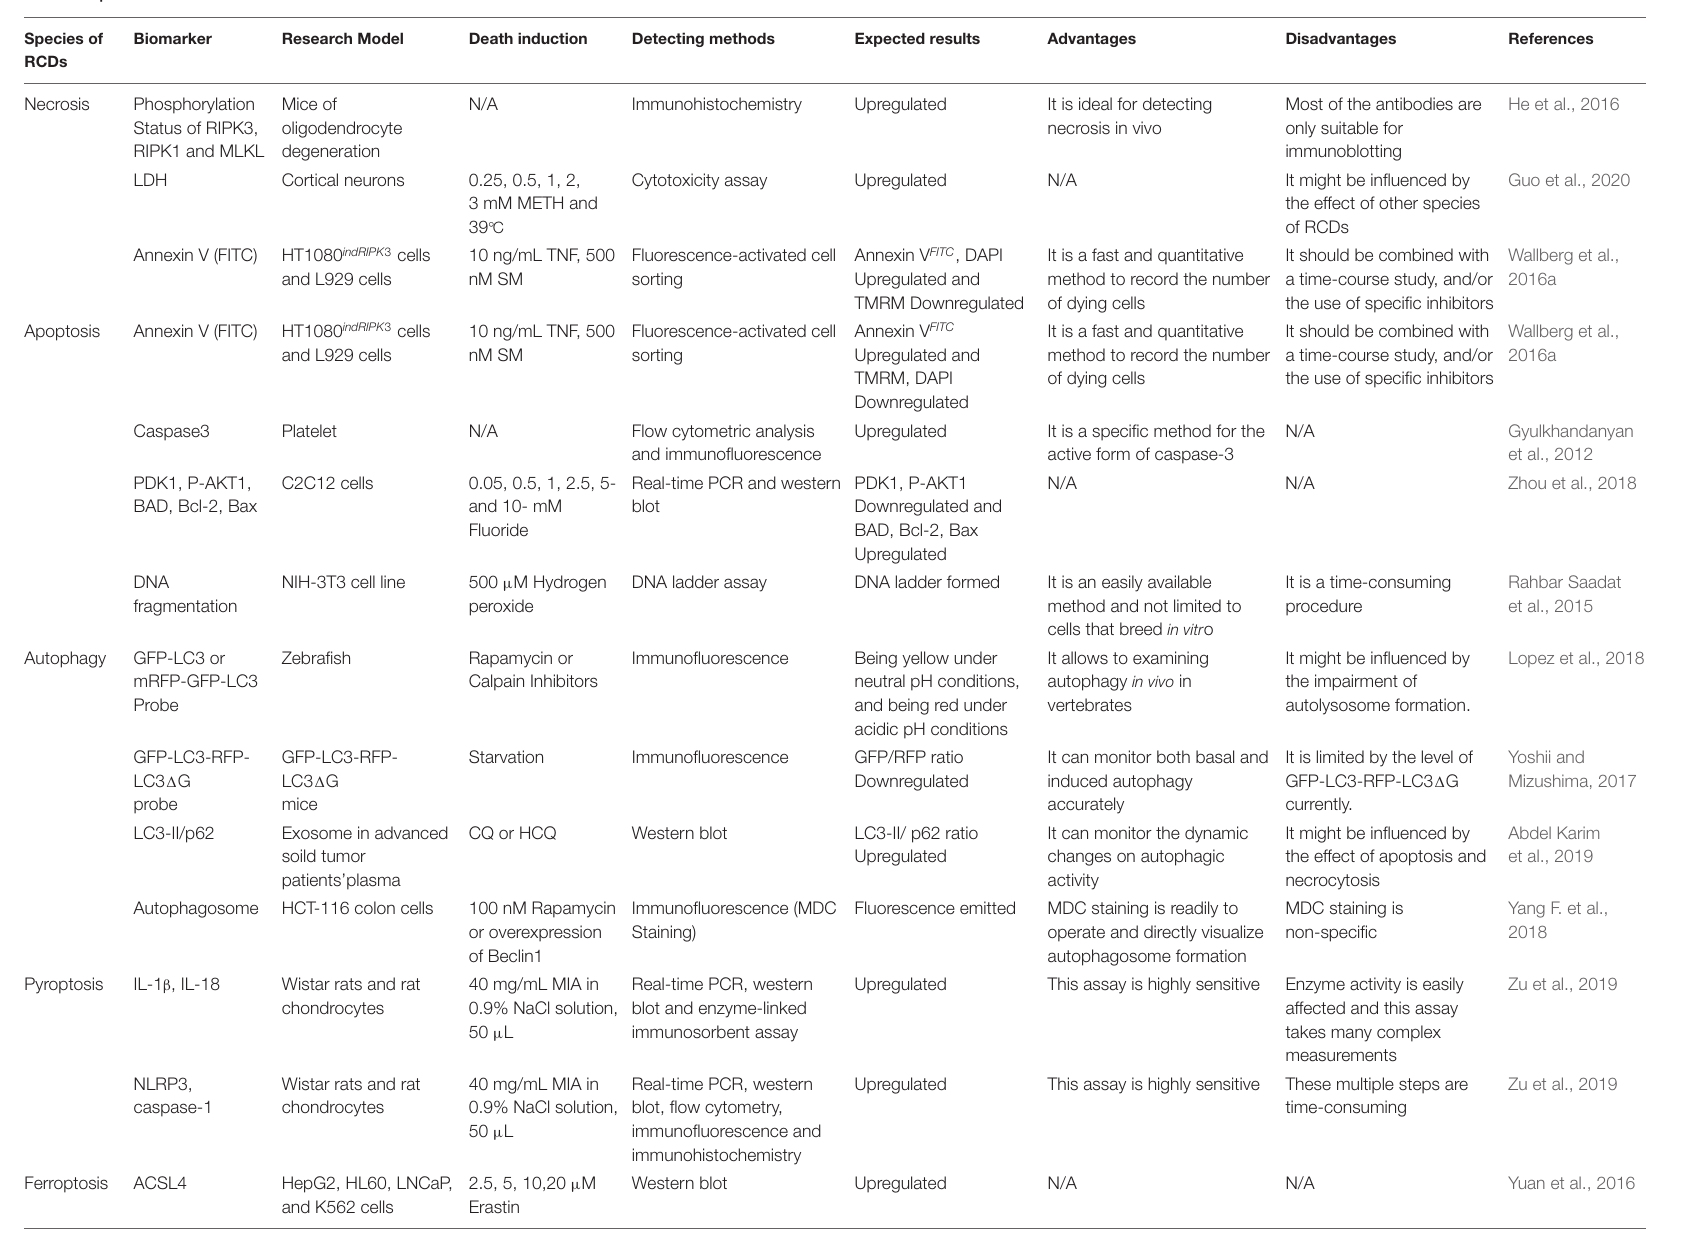
TABLE 3 | Conventional biomarkers for